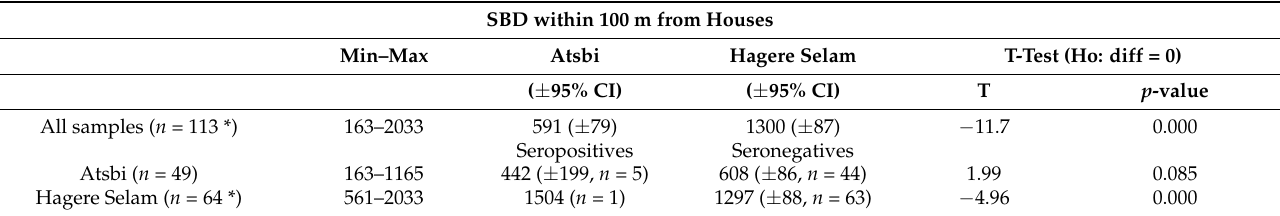
Table 5. Outputs from two sample t-tests. Comparison of average stone bund density (SBD) between Atsbi and Hagere Selam as well as comparison of average SBD between seropositive and seronegative samples.